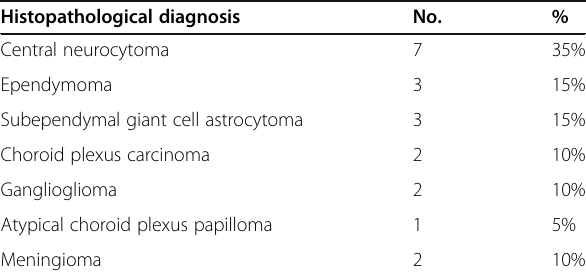
Table 4 Histopathological diagnoses Histopathological diagnosis No.